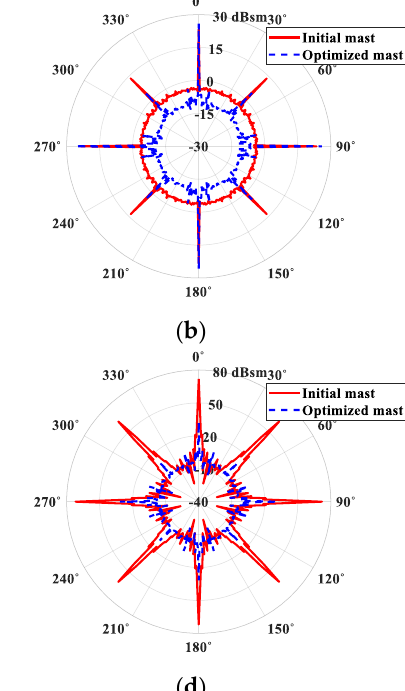
Figure 7. RCS pattern of the integrated mast in the azimuth plane in the S-band. ( a ) HH polarization at an elevation angle of 0°, ( b ) VV polarization at an elevation angle of 0°, ( c ) HH polarization at an elevation angle of 10°, ( d ) VV polarization at an elevation angle of 10°.